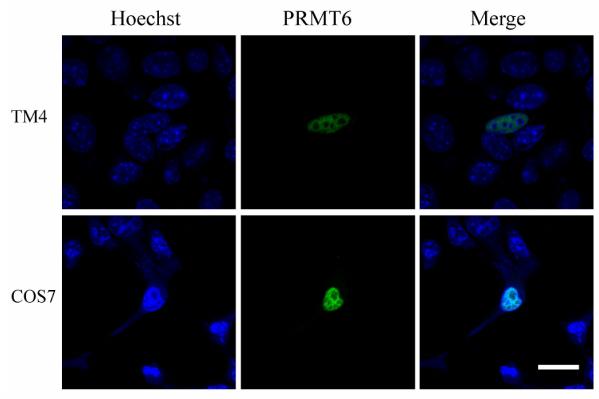
Figure 3. Sub-cellular localization of PRMT6 in TM4 and COS7 cells. The recombinant EGFP-PRMT6 plasmid was transiently transfected into TM4 and COS7 cells. The EGFP-PRMT6 protein (green) was expressed in TM4 and COS7 cells. The nuclei of the cells were stained with Hoechst 33342 (blue). Bar = 20 µ m.